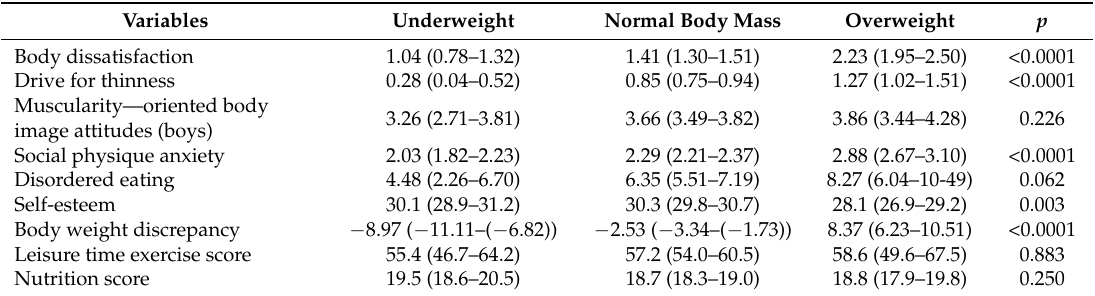
Table 2. Comparison of body image concerns and exercise between body mass groups (m, 95% CI) 1 , ( n =